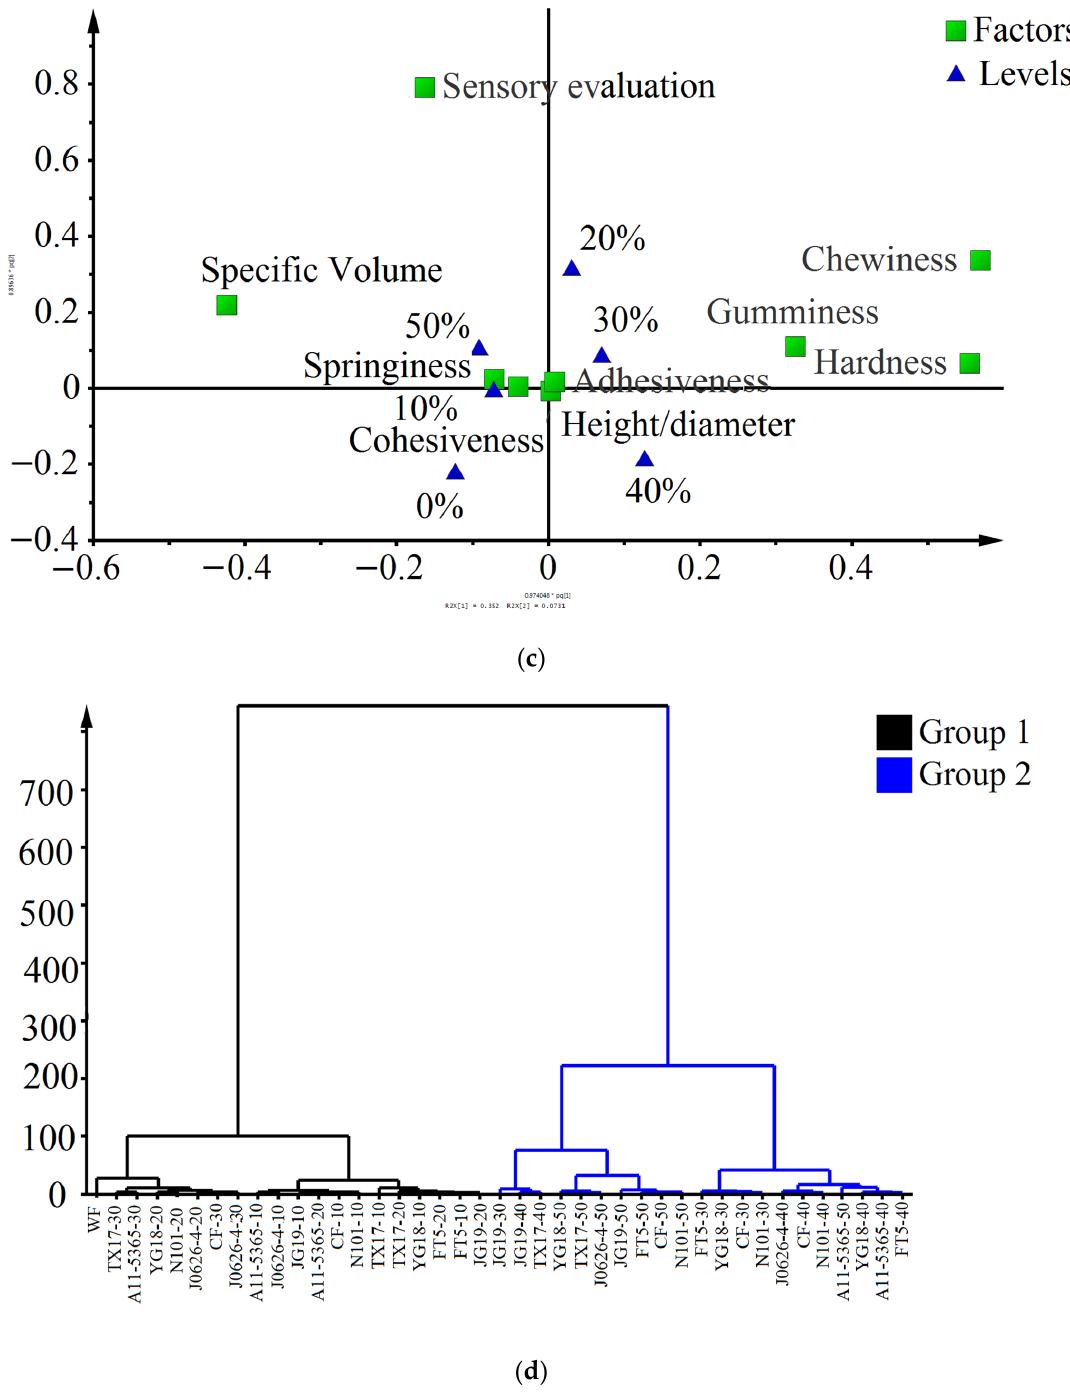
Figure 1 ( a ) OPLS-DA score plot; ( b ) VIP; ( c ) loading plot; ( d ) clustering results. Figure 1. ( a ) OPLS-DA score plot; ( b ) VIP; ( c ) loading plot; ( d ) clustering